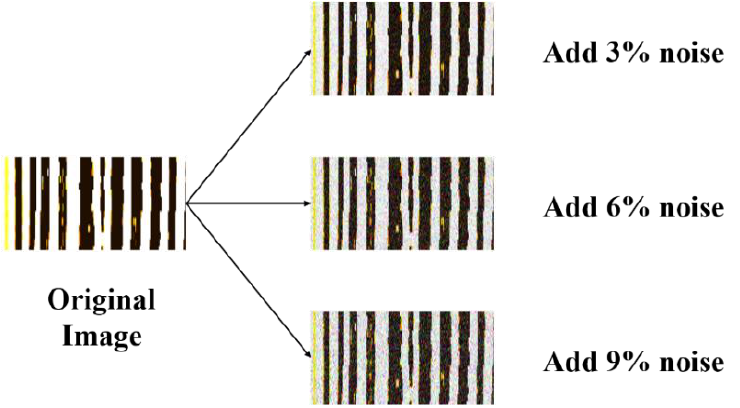
Figure 13. Adding white noise to the original image.